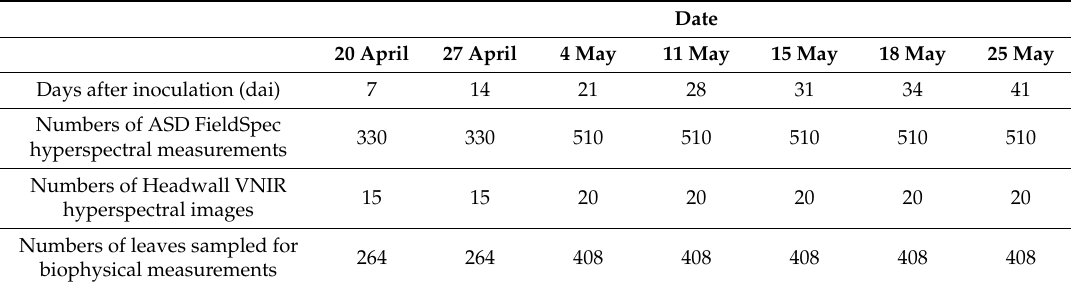
Table 1. Observation schedule and measurement characteristics of the